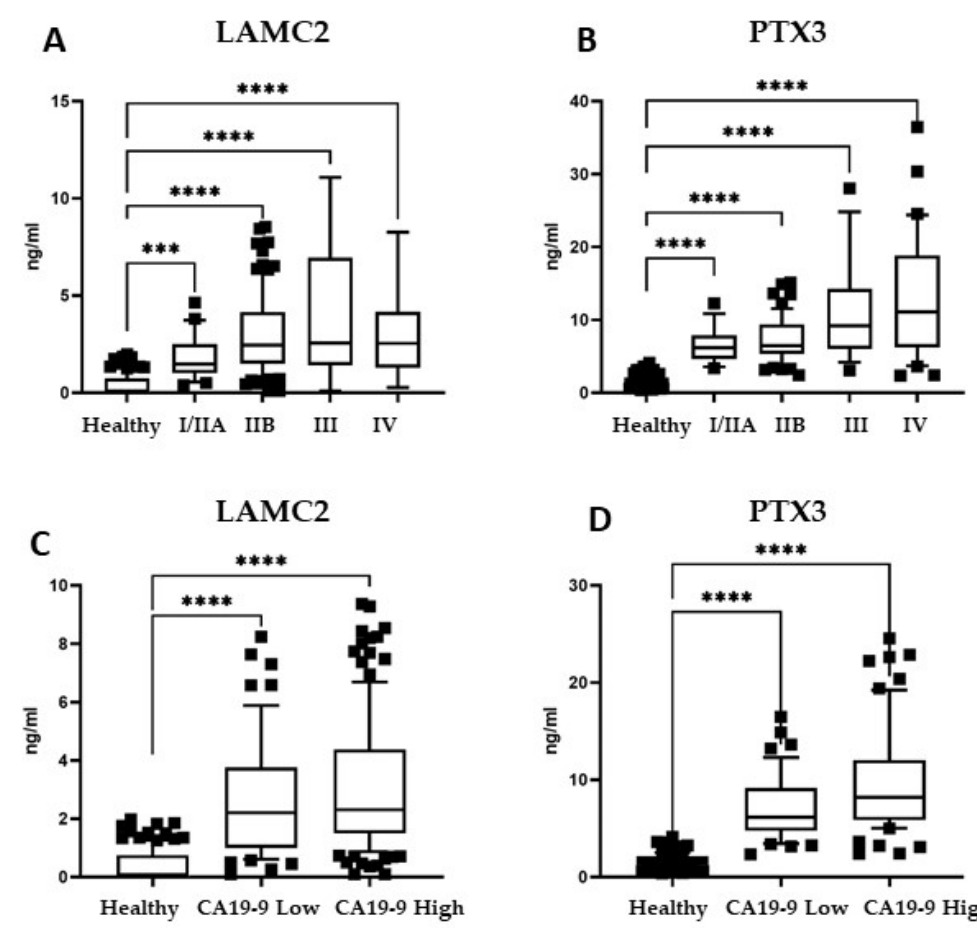
Figure 5. Biomarker panel quantification in early-stage PDAC patients and in patients with low levels of CA19.9. Plasma levels of ( A ) LAMC2 and ( B ) PTX3 quantified by ELISA in PDAC patients according to their stage, as detailed in Table I. Plasma levels of ( C ) LAMC2 and ( D ) PTX3 quantified by ELISA in PDAC patients with low CA19-9 values of <37 U/mL ( n = 58 patients) and in PDAC patients with high CA19-9 values of >37 U/mL ( n = 142 patients). Results are analyzed in comparison with the total number of healthy volunteers ( n = 135). Statistical analysis: one-way ANOVA, outliers eliminated with «Identifying outliers» ROUT, *** p < 0.001, **** p < 0.0001. Boxes correspond to values comprised between 10 and 90 percentiles.